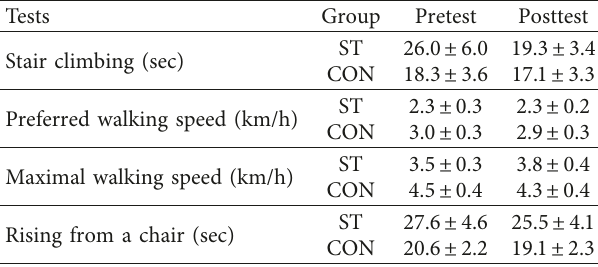
Table 2: Pre- and posttest results of physical function for the ST and